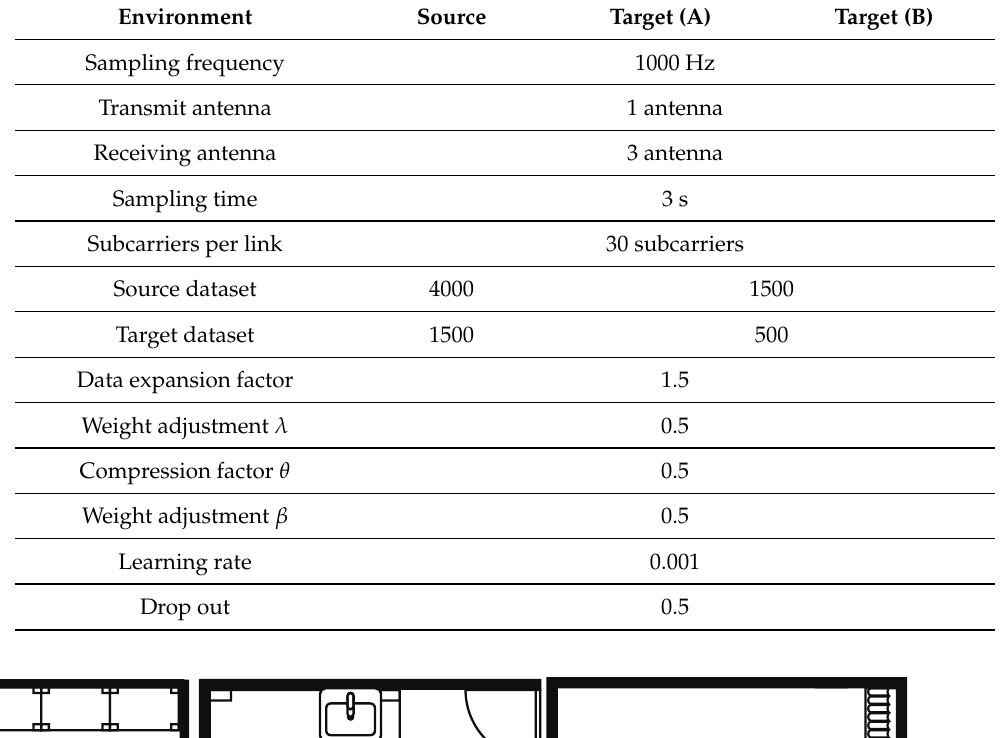
Table 1. Experiment parameter.